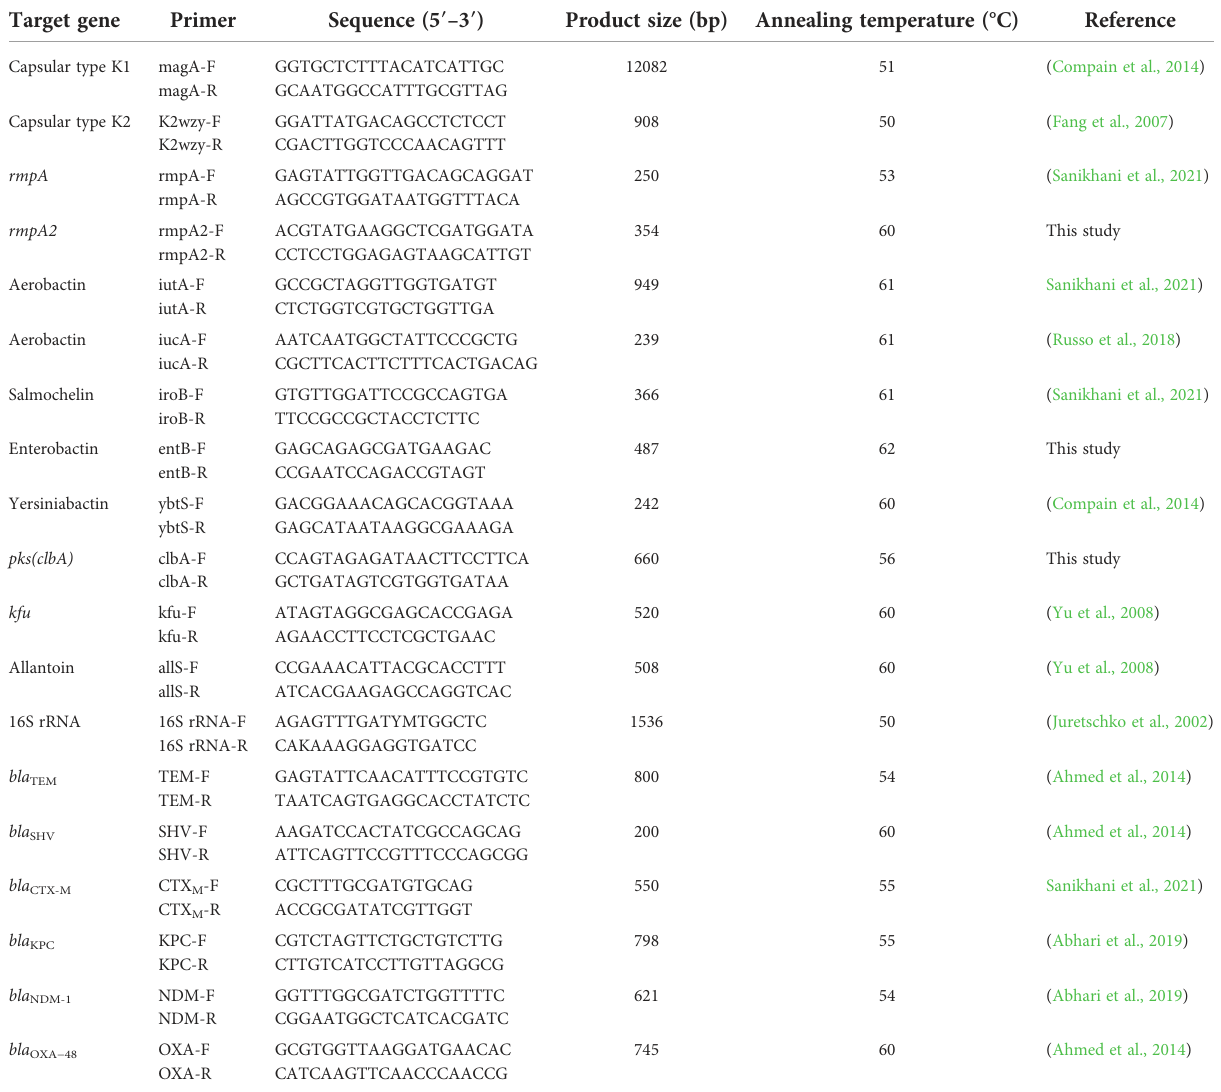
TABLE 1 Speci fi c pairs of primers were used to amplify the target genes of K. pneumoniae in this